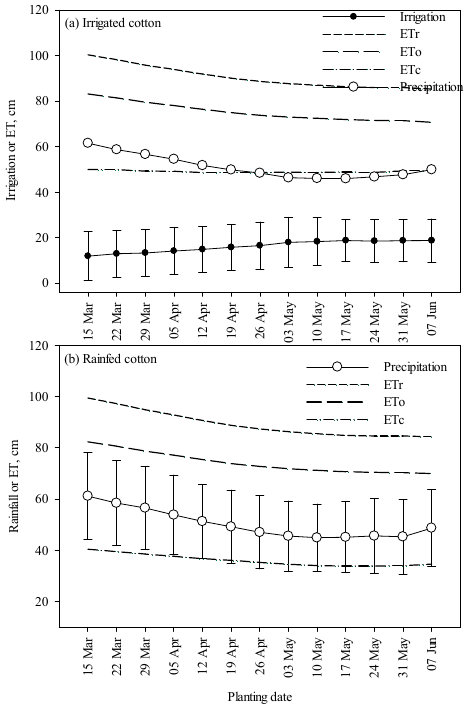
Figure 6. Long-term average (1960–2015) evapotranspiration for short grass (ETo) and alfalfa (ETr) reference crops and simulated crop evapotranspiration (ETc), irrigation, and precipitation during the cotton growth period occurred each year. The crops were planted at weekly intervals between March and June from 1960 to 2015 under rainfed ( a ) and irrigated ( b ) conditions at Stoneville, MS.